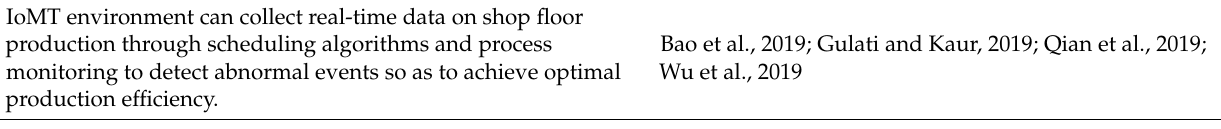
Table 5. Synopsis of evidence regarding analyzed topics and descriptive outcomes (research